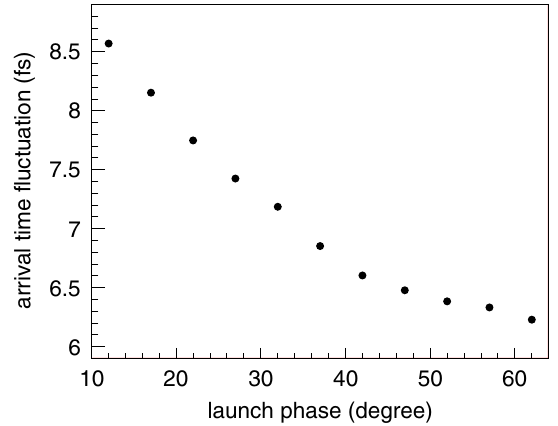
FIG. 13. Beam arrival time sensitivity at 0.45 m to 0.013% gun rf amplitude jitter at the gun phase when the beam is launched. Arrival time fluctuation to rf amplitude jitter becomes smaller as the launch phase increases. This arrival time fluctuation is partially compensated by the rf buncher (see Fig. 16 and the discussion in the